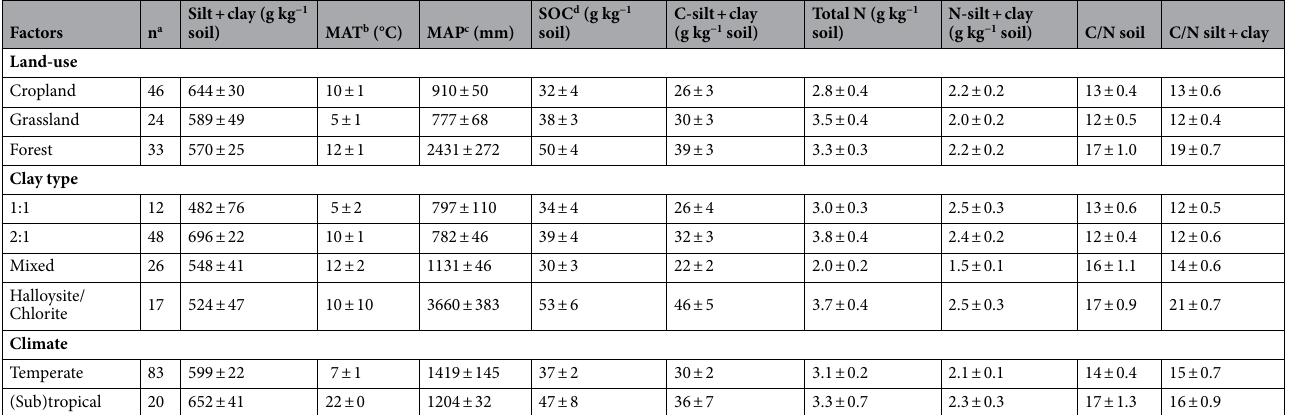
Table 1. Soil characteristics from 15 studies published results of 103 bulk soil and fine particle size < 63 µm (± standard error of the mean). Matus et al. 9 ; Anderson et al. 42 ; Angers and N’Dayegamiye 43 ; Catroux and Schnitzer 44 ; Elustondo et al. 45 ; Gregorich et al. 46 ; Leinweber and Reuter 47 ; Mc Keague 48 ; Matus and Maire 49 ; Matus et al. 50 ; Schulten and Leinweber 6 ; Shang and Tiesse 51 ; Tiessen and Steward 52 ; Turchenek and Oades 53 and Schmidt et al. 54 . a Soil N was obtained from 76 bulk soil samples and 68 particle size fractions. b Mean annual temperature. c Mean annual precipitation. d Soil organic